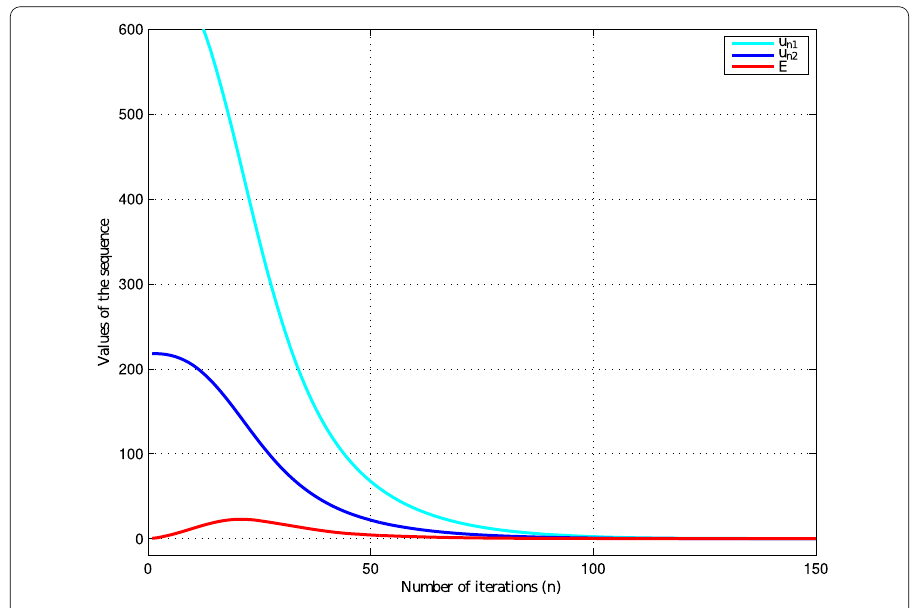
Figure 1 Convergence result of Theorem 3.5 with starting point of Case 1